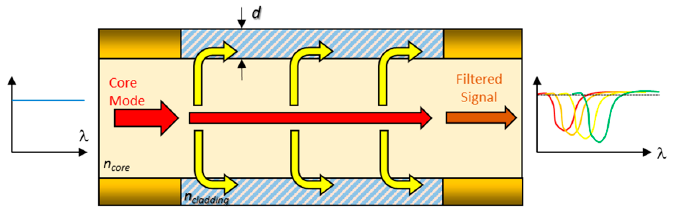
Figure 8. Schematic representation of a LMR: the optical resonance expressed as a transmission valley is increased and shifted if the thickness of the coating or its refractive index is modified.